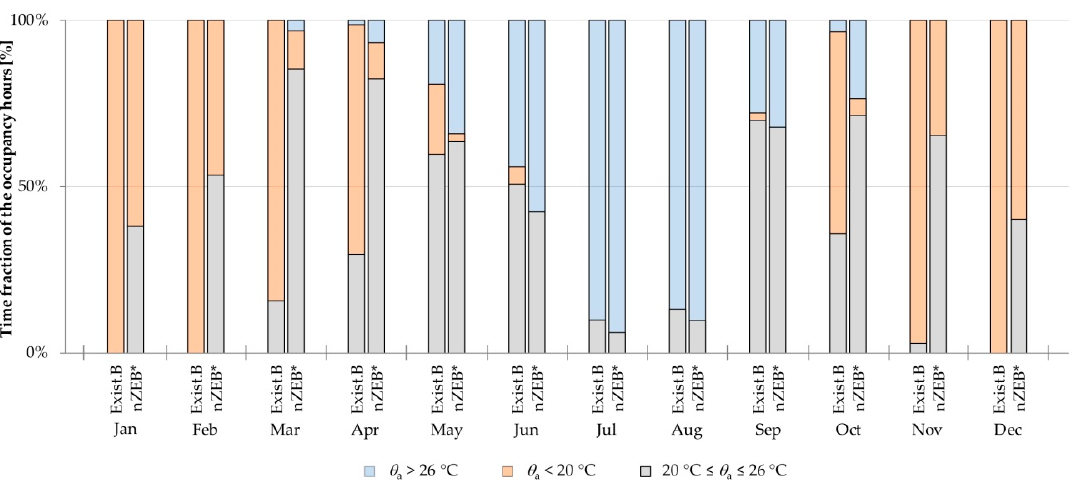
Figure 4. Comparison of the free floating time between the building in the current condition (Exist.B) and considering the retrofit of the building envelope (nZEB*) on a monthly basis.